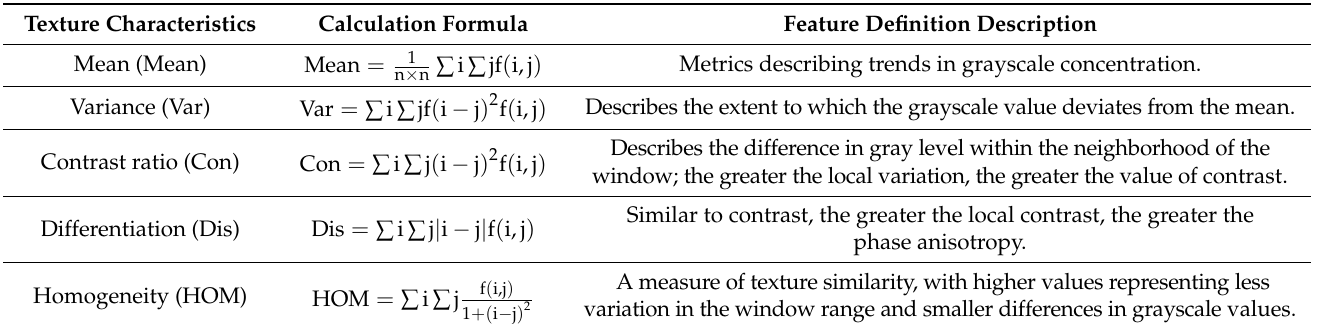
Table 1. Texture feature calculation formula and